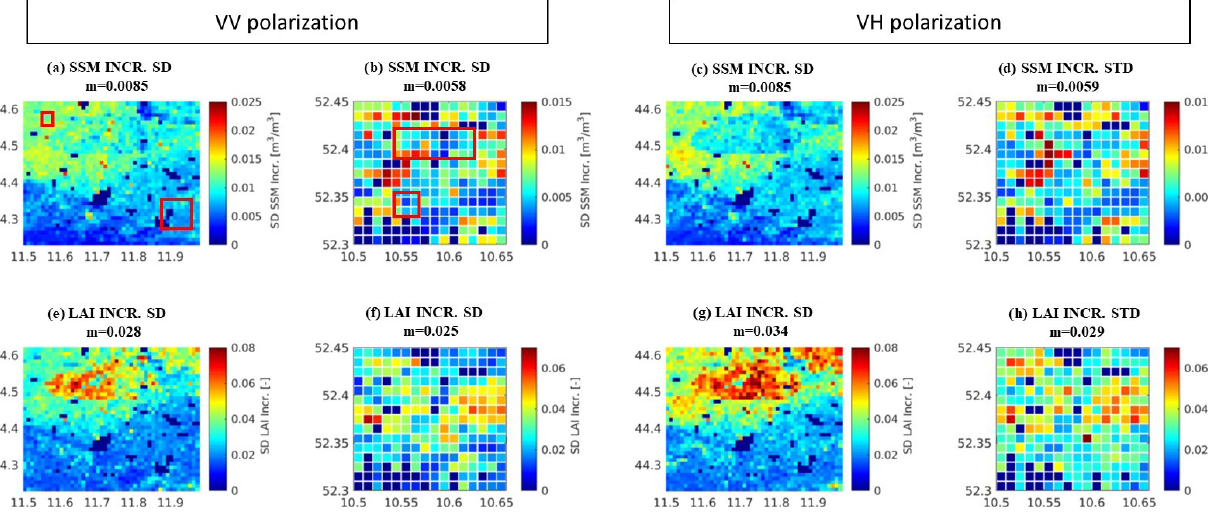
Figure 5. Same as Fig. 3 but for the standard deviation (SD) of the increments in (a–d) SSM and (e–h) LAI. Red boxes in (a) and (b) indicate areas where the test sites are located.